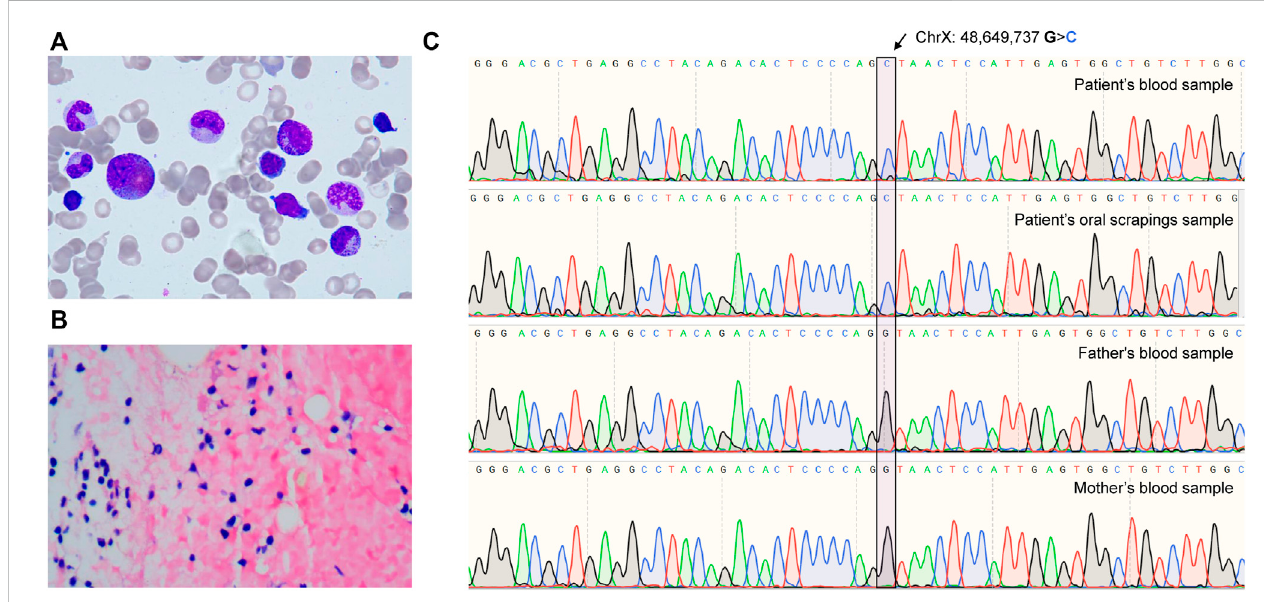
FIGURE 1 The de novo GATA1 mutation-induced Diamond-Blackfan-like syndrome. (A) Images of bone marrow aspirates from patients taken with 100 × magni fi cation. (B) A 40 × magni fi cation bone marrow sample revealed hypercellular bone marrow and a fl orid population with reduced erythropoiesis. (C) Sequencing chromatograms from patient ’ s and parents ’ GATA1 mutations (chrX: 48,649,737 G > C in